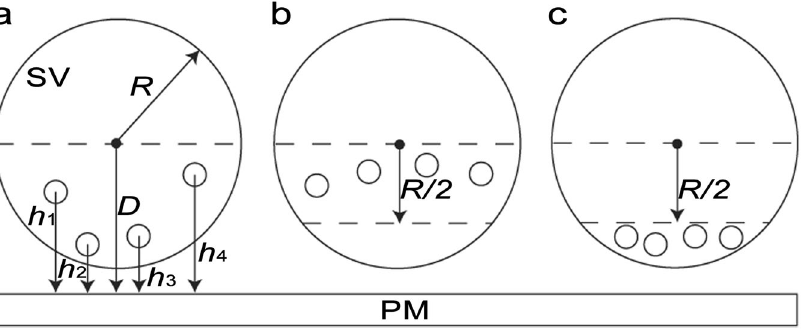
Figure 2. Schematic diagrams of three SVs having different arrangements of multiple connection sites of AZM macromolecules on the SVs and parameters that quantify the spatial relationships of the SVs and the connection sites with the PM. Schematic diagrams show three SVs having different arrangements of multiple AZM macromolecules (open circle) on their hemispherical surfaces facing the PM. Each SV is idealized to be a sphere with a radius, R , and the height of each AZM connection site is the distance from the AZM connection site to the PM where h i is the height of the i -th AZM connection site where i = 1, 2, … , n (the total number of the AZM connection sites). The proximity of each SV’s center to the PM ( D ) is used to determine the spatial relationship between the SV and the PM. Thus, the proximity of each SV is greater than R when the SV is undocked from the PM, and the proximity is less than R when the SV is docked with the PM. For docked SVs, D is used to obtain the contact area of the SVs with the PM. ( a ) Multiple AZM connection sites are randomly distributed on the entire hemisphere of an SV, which is the region below the dotted line on the SV. ( b ) The AZM connection sites are distributed randomly on the upper half hemisphere of an SV, which is the region between the two dotted lines on the SV. ( c ) The AZM connection sites are distributed randomly on the lower half of the hemisphere of a SV, which is the region below the dotted line in the middle of the SV’s